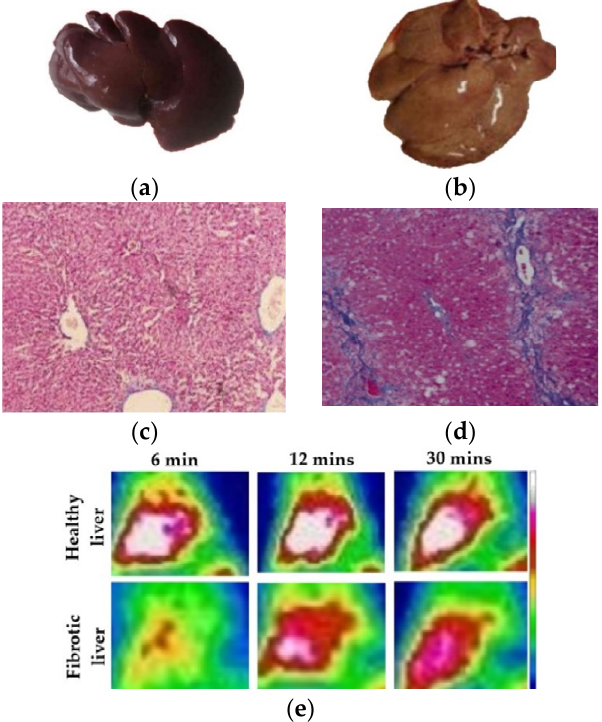
Figure 7. Characterization of a CCl 4 -induced rabbit model of liver fibrosis. Representative images of: ( a ) Normal liver; ( b ) Fibrotic liver: Masson’s stained liver tissue of; ( c ) control; ( d ) fibrotic liver after CCl 4 administration for 9 weeks, fibrotic liver tissue is showing increased collagen (purple); ( e ) Representative 99m Tc-Q9P35GC dynamic SPECT images at different time points for fibrotic and healthy liver.